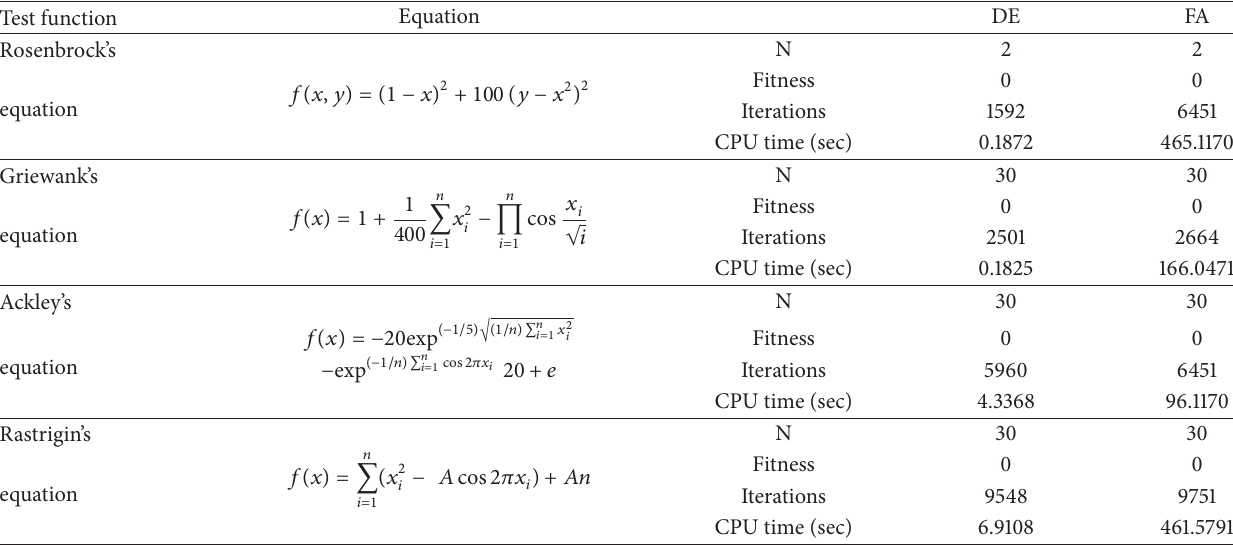
Table 2: Run time and fitness comparison of standard